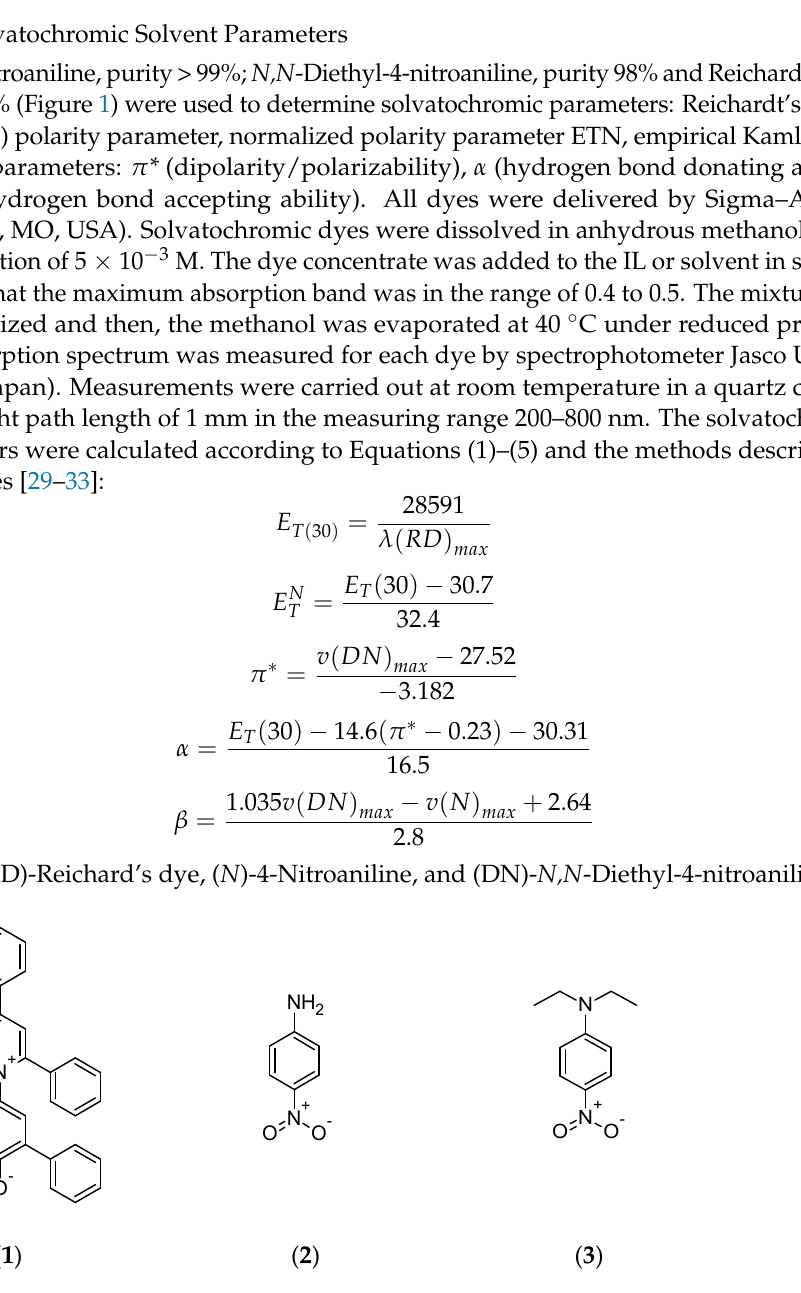
Figure 1. The structures of solvatochromic dyes: ( 1 ) Reichardt’s dye, ( 2 ) 4-Nitroaniline, ( 3 ) N,N -